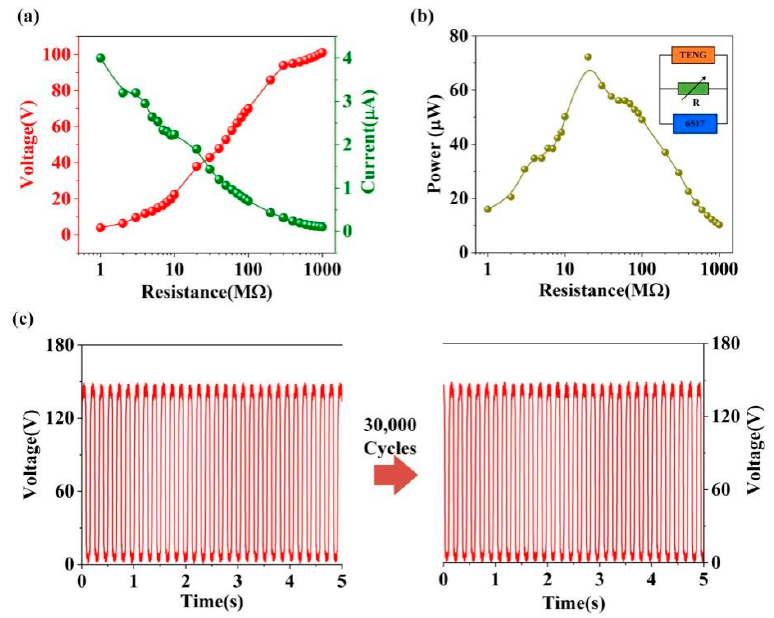
Figure 4. ( a ) The output voltage and output current of DL-TENG under different loads. ( b ) The output power of DL-TENG under different loads. ( c ) The reliability test of the DL-TENG.